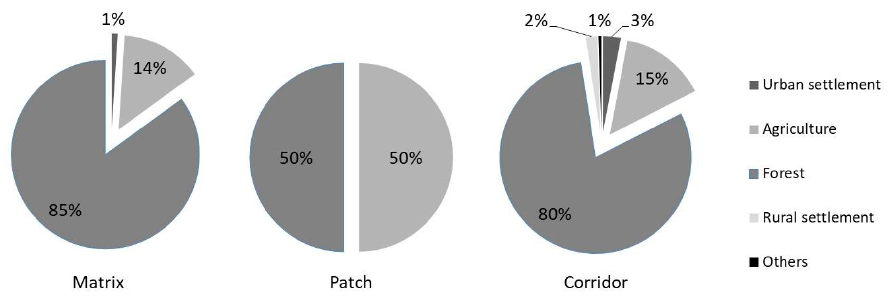
Figure 9. The proportional distribution of the land cover types in the GI elements.